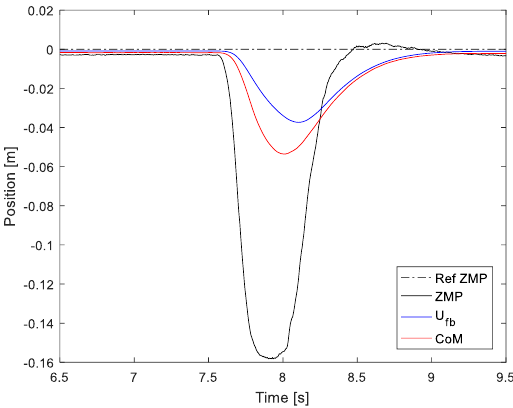
Figure 5. Block diagram of previous ZMP control without capture-point feedback. Figure 6. Control input and measured ZMP when the robot is perturbed.